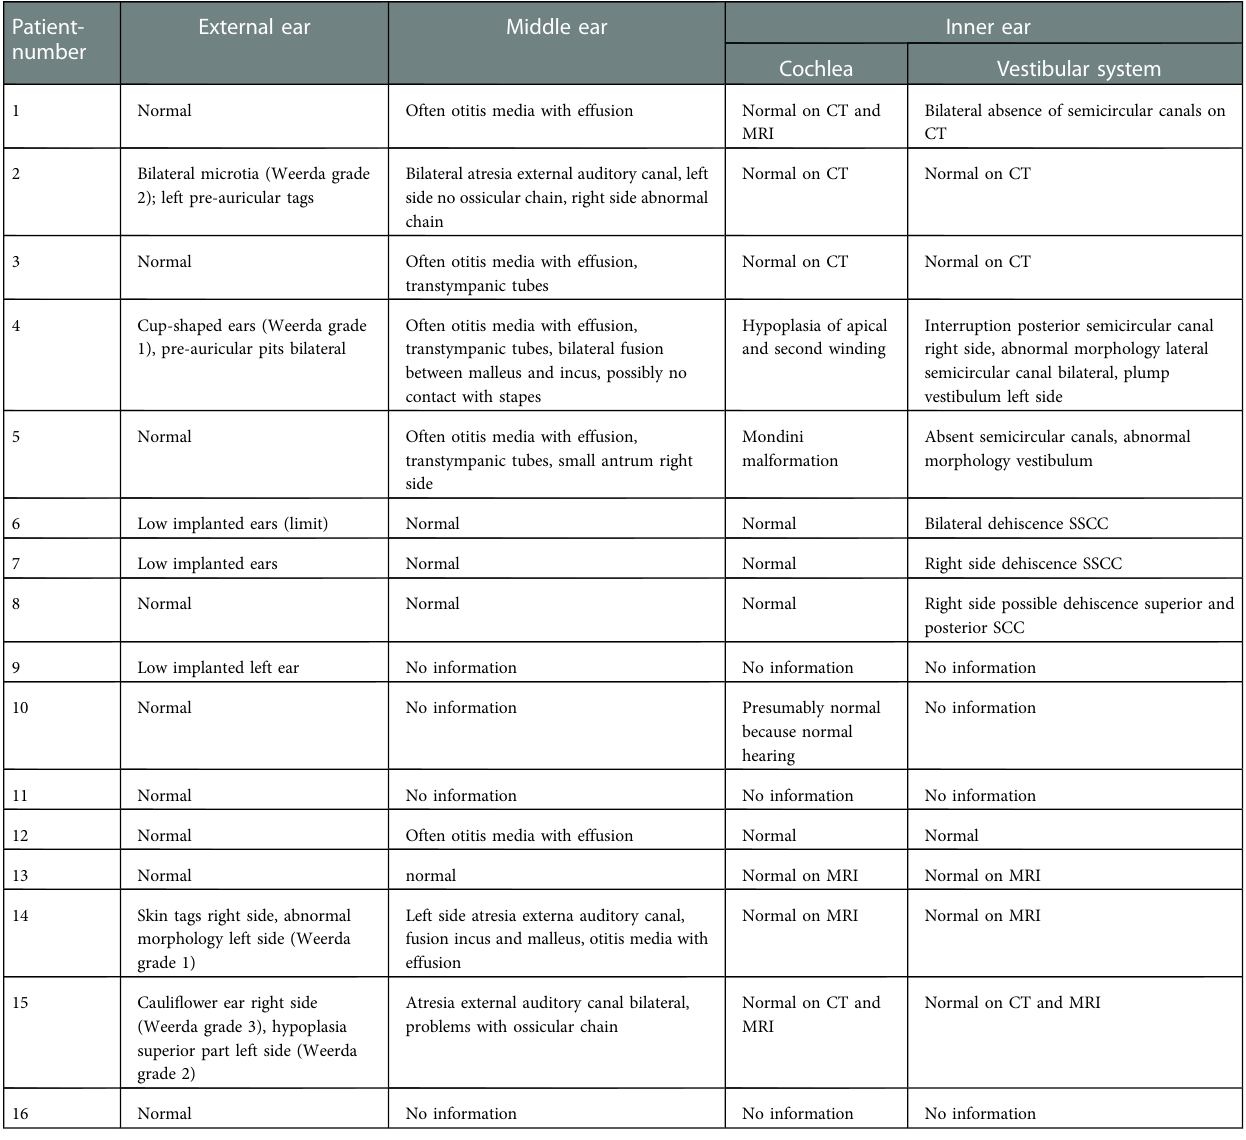
TABLE 4 Deformations outer, middle and inner